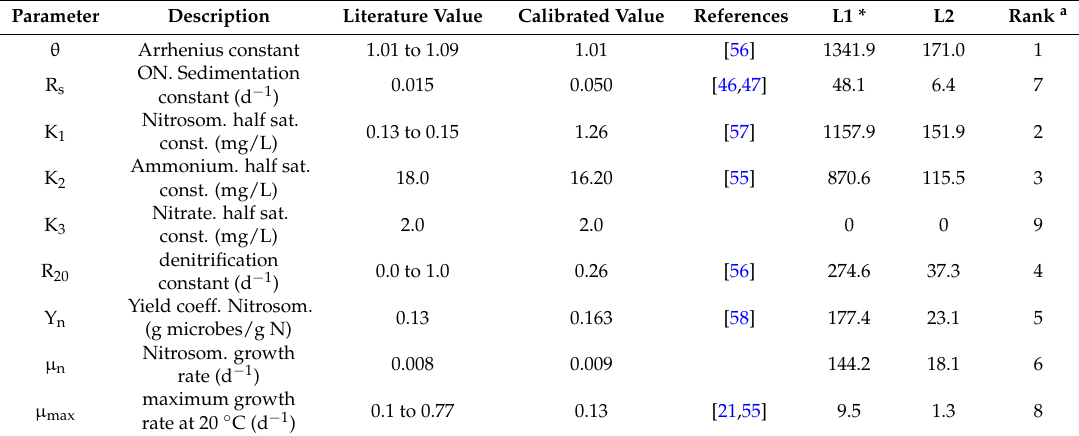
Table 2. Model calibration parameter values with summary statistics of parameters’